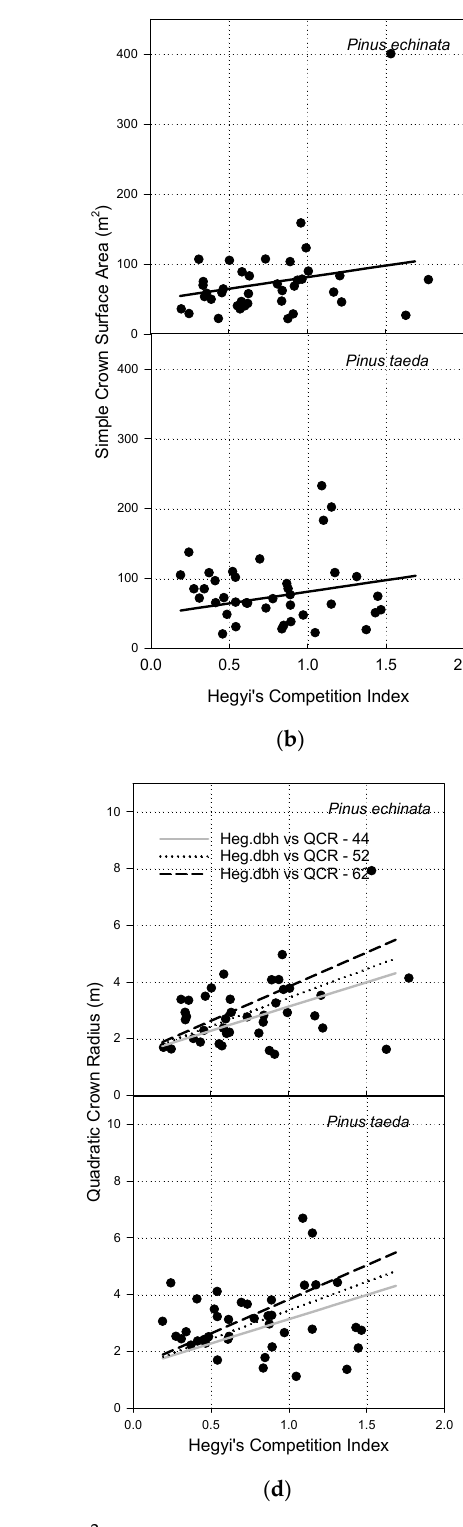
Figure 4. Focal tree: ( a ) mean crown surface area (m 2 ; truncated paraboloid surface area); ( b ) simple crown surface area (m 2 ; quadratic width × length); ( c ) crown projection area (m 2 ); and ( d ) crown radius (m) as functions of competition indices for shortleaf ( Pinus echinata ) and loblolly pine ( Pinus taeda ) in mature, natural-origin, pine-hardwood mixtures of southeastern Arkansas. Multiple lines for surface area, projection area, and radius represent responses at various diameters at breast height (44 cm, 52 cm, and 62 cm) due to a significant ( p < 0.05) interaction term.